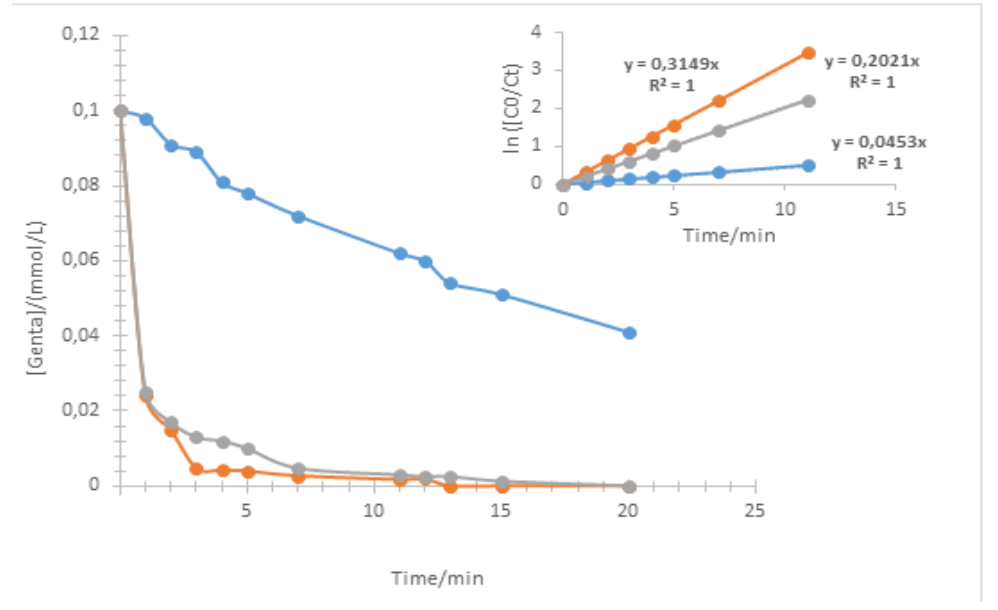
Figure 1: Influence of the applied current to the diminution of the concentration of the gentamicin during electro-Fenton treatment and the apparent rate constants. pH = 3, [Genta] M, V = 200